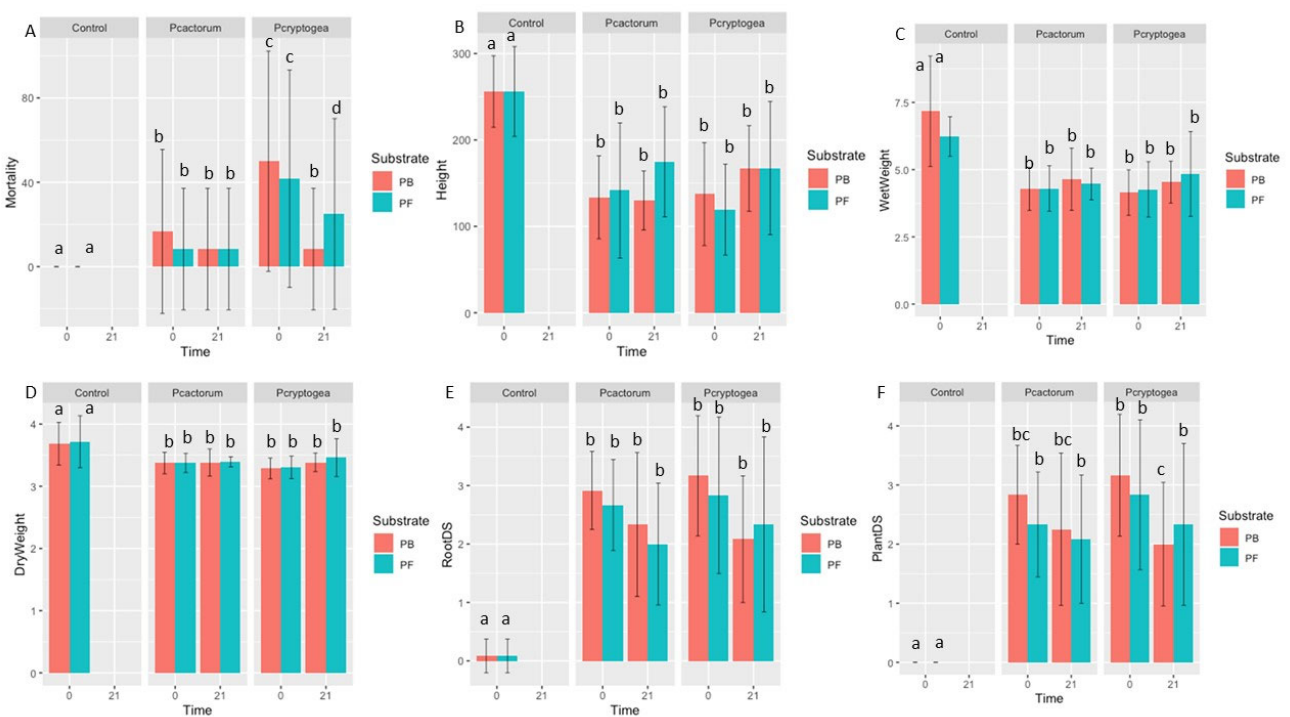
( P. cryptogea 0), E. globulus had 60% and 50% mortality rates in PB and PF substrates, respectively (Table 2, Figure 5). These differences compared to the controls were significant in the PB substrate but not significant in the PF substrate ( p = 8.254 × 10 − 3 ; p = 0.06176, respectively). For E. globulus planted into 21-month-old P. cryptogea pots ( P. cryptogea 21), 10% and 30% mortality occurred in PB and PF substrates, respectively; the differences in mortality compared to the control were significant in PB but not significant in PF ( p = 8.254 × 10 − 3 ; p = 0.06176, respectively).